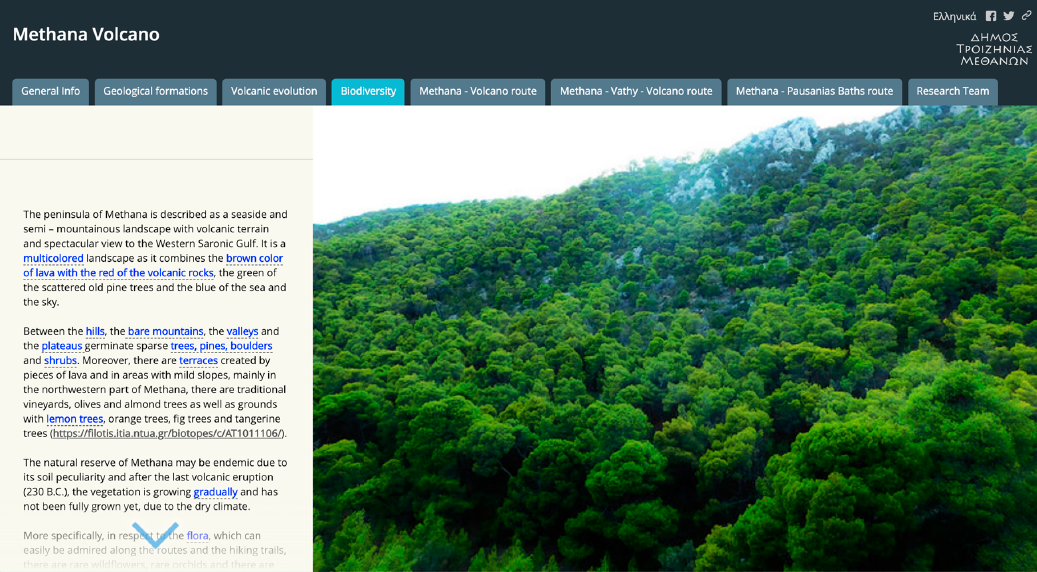
Figure 13. Screenshot of the fourth tab, where narrative text, multimedia context and internal links is